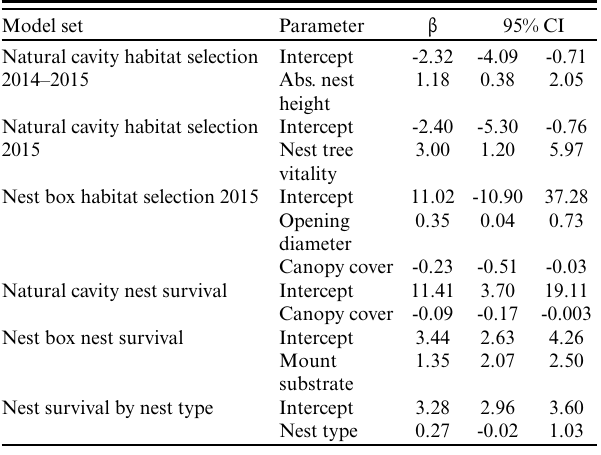
Table 5 . Top three models (and null) describing habitat selection Table 6 . Summary of parameter estimates for variables included of microhabitat features of natural cavity nest sites (vs. random in the top models describing habitat selection and nest survival cavity sites; A and B) and nest boxes (C) by Prothonotary Warblers of Prothonotary Warblers ( Protonotaria citrea ) nesting in White ( Protonotaria citrea ) in 2014–2015 at White River National River National Wildlife Refuge, Arkansas, USA in Wildlife Refuge, Arkansas, USA. All models included a random variable of territory ID to pair used nests with the random cavity within a territory. Subset A included nests from 2014–2015 (n = 57), for which seven microhabitat variables were measured (7 models built, AIC of top model = 153.42). Subset B includes c nests from 2015 only (n = 23), for which 11 microhabitat variables were measured (11 models built, AIC of top model = 57.60). c Habitat selection for nest boxes (n = 57) was assessed for nests in 2015 only (8 models built; AIC of top model = 60.53). c